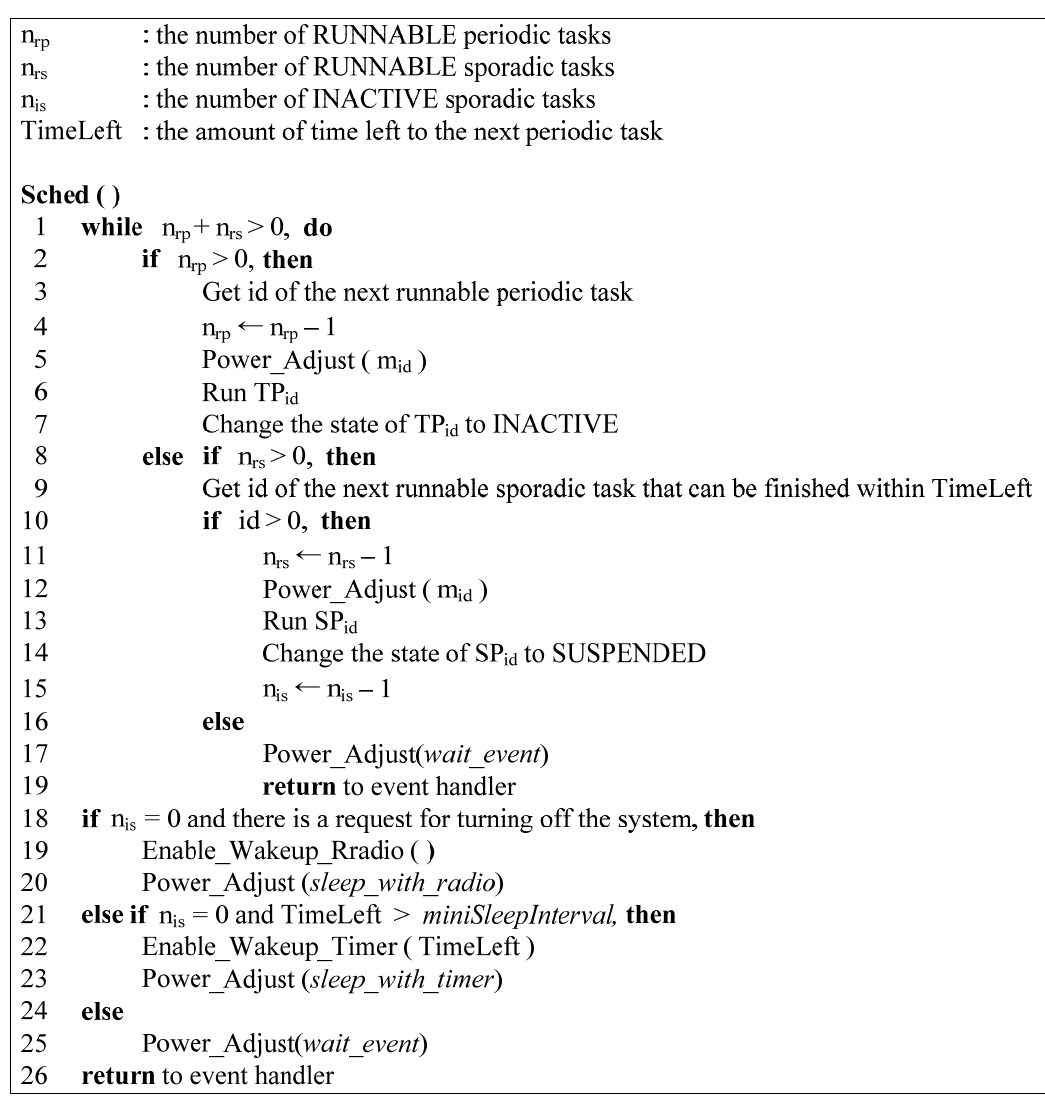
Figure 6. Operations of on-time power-aware